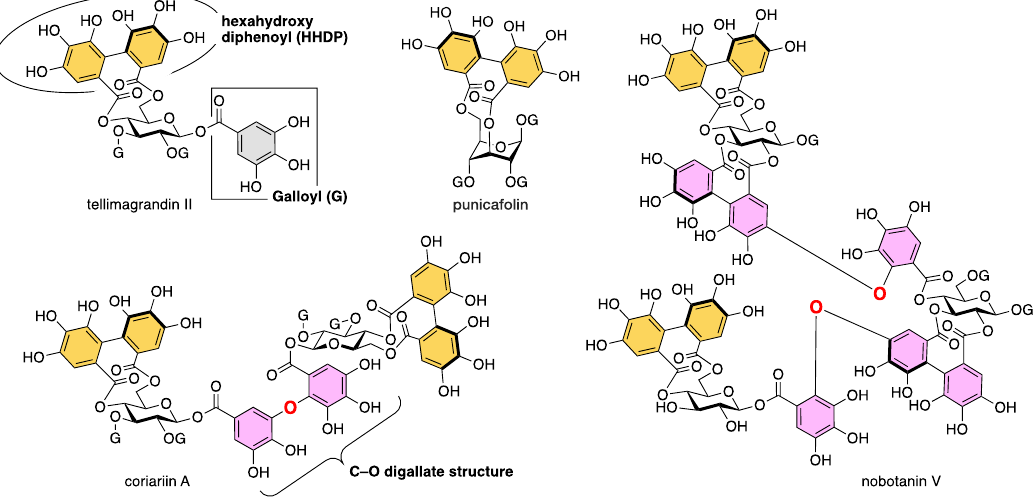
Figure 1. Representative structures of ellagitannins. G: galloyl; HHDP: hexahydroxydiphenoyl.